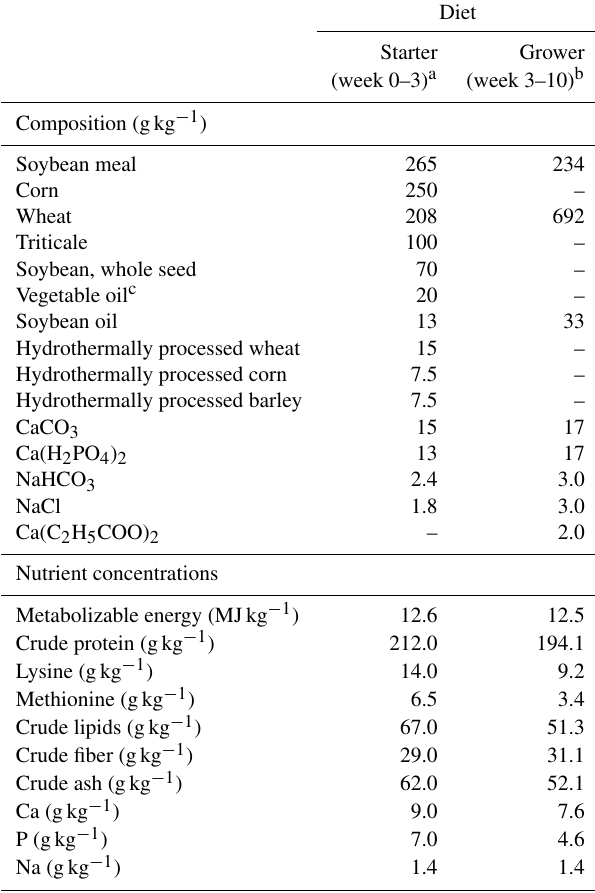
Table 1. Composition and main characteristics of